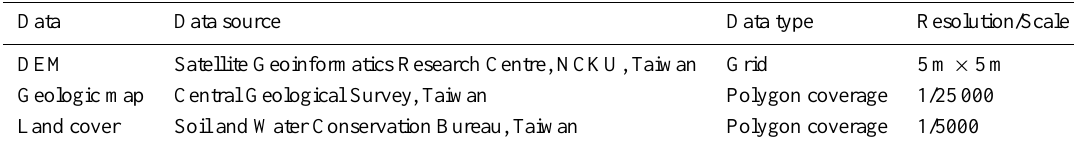
Table 1. Data sources and data types used in this